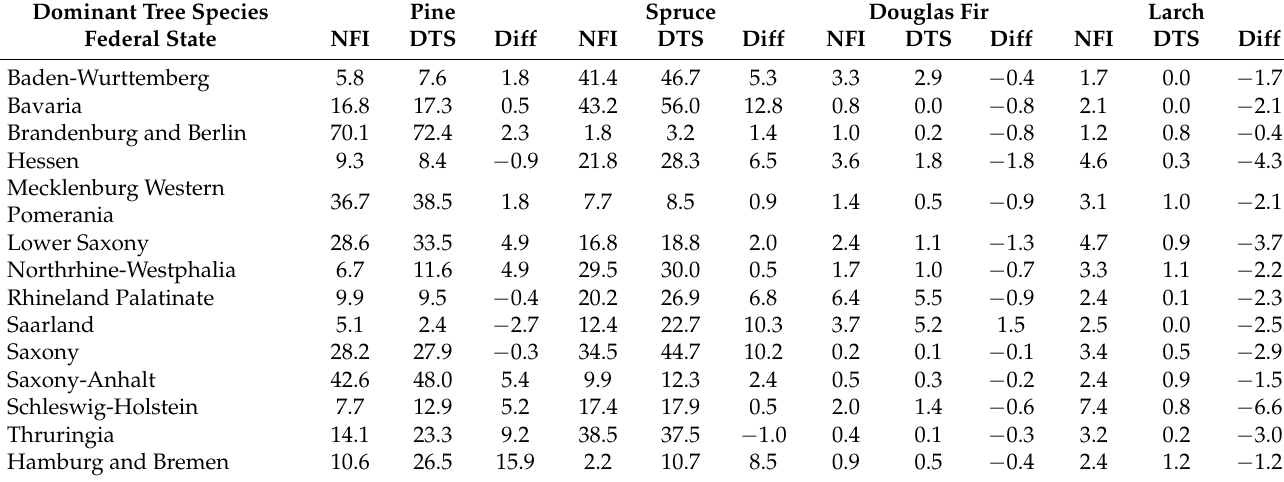
Table 2. Percentage of area covered by each tree species in the forest area per federal state. Comparison of NFI data and the classification (DTS). Diff shows the difference in percentages for coniferous